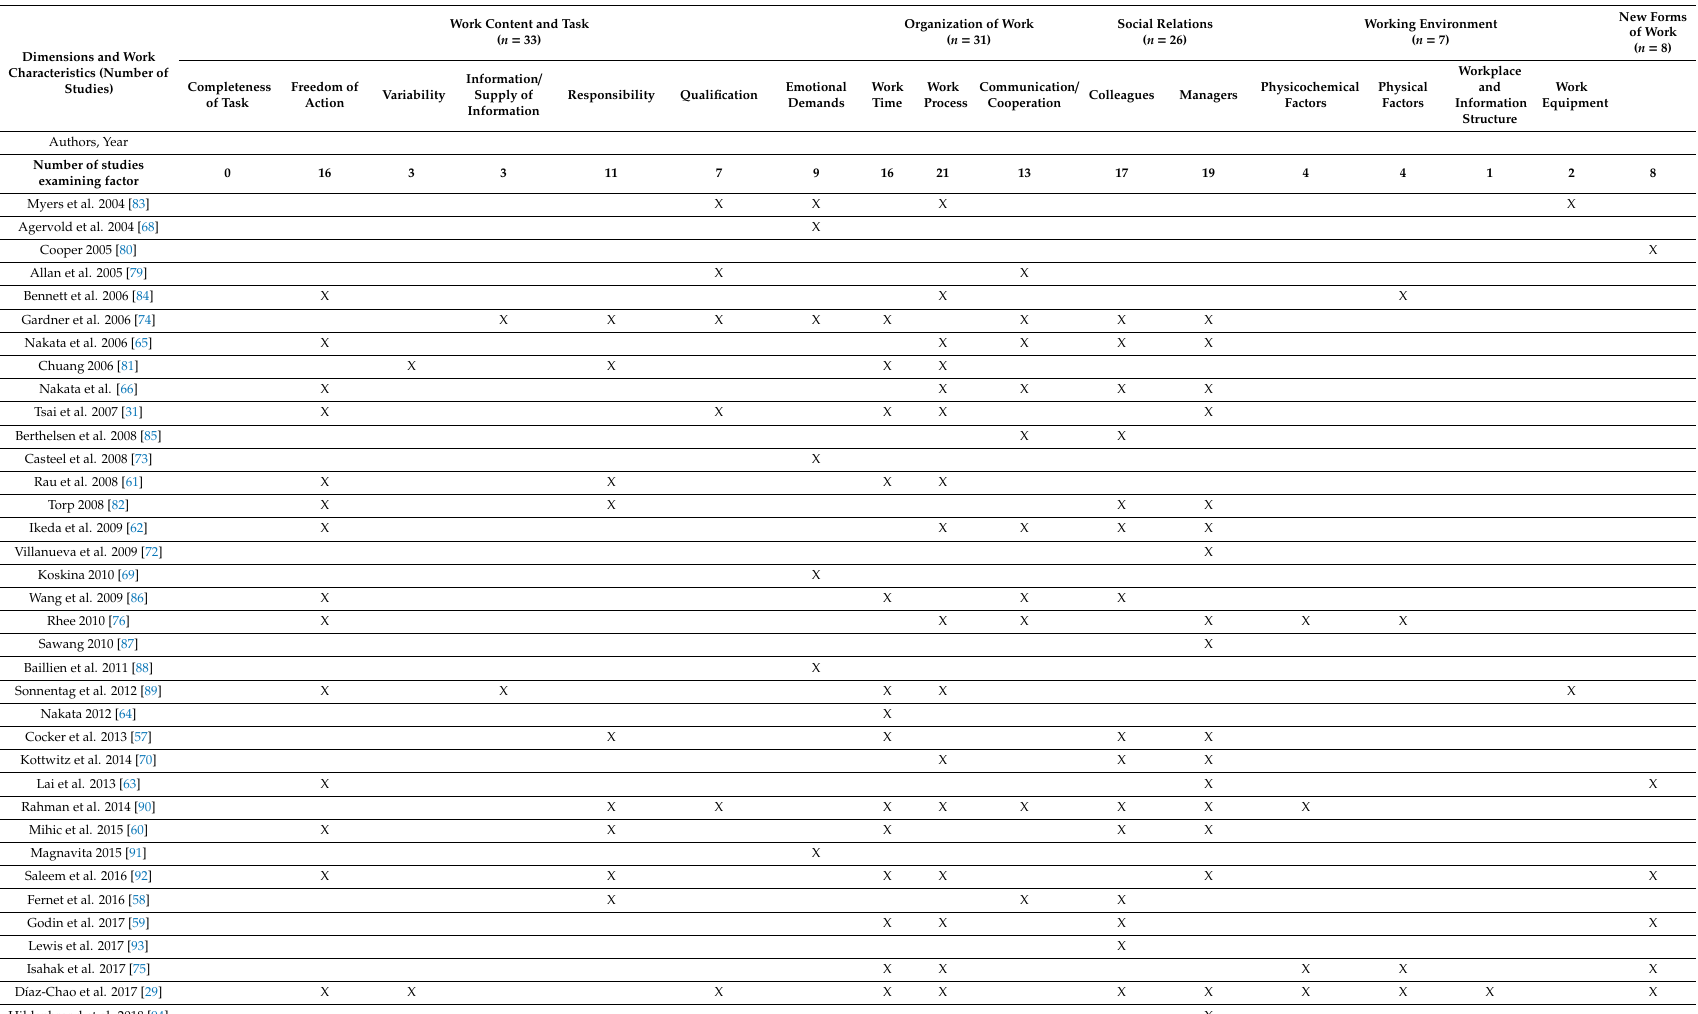
Table 1. Allocation to Dimensions of Psychosocial Factors and Single Work Characteristics According to Beck et al. 2014 [39].